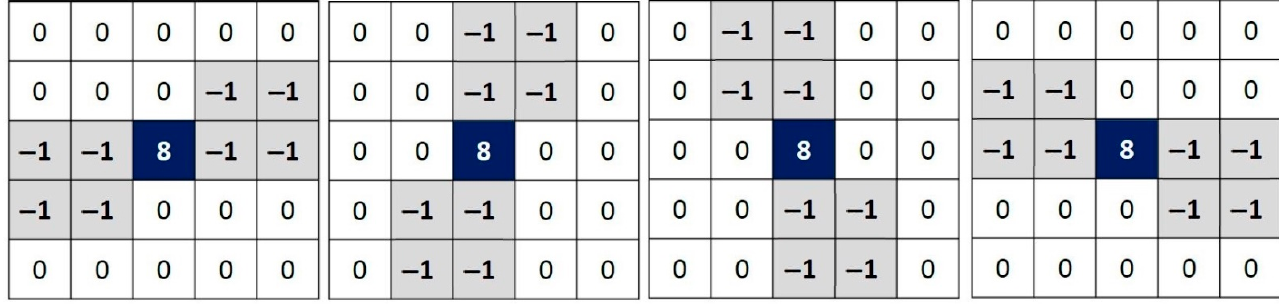
Figure 3. Proposed four new kernels according to the directions π /8, 3 π /8, 5 π /8, and 7 π /8. Identification of corrupted pixels can still fail against a high percentage of impulsive